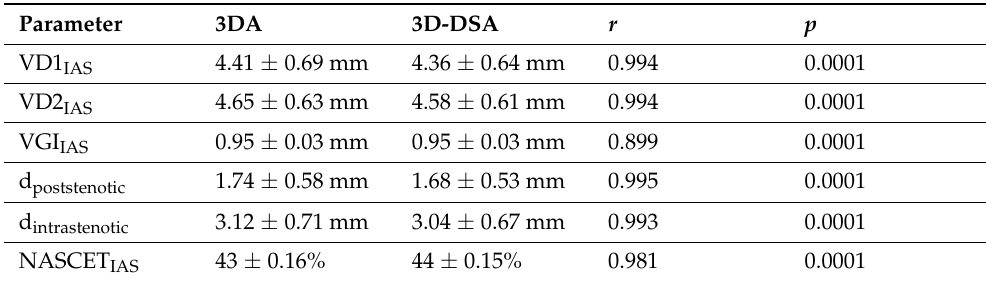
Table 2. Vessel diameters (VD), vessel-geometry index (VGI), NASCET graduation of IAS.